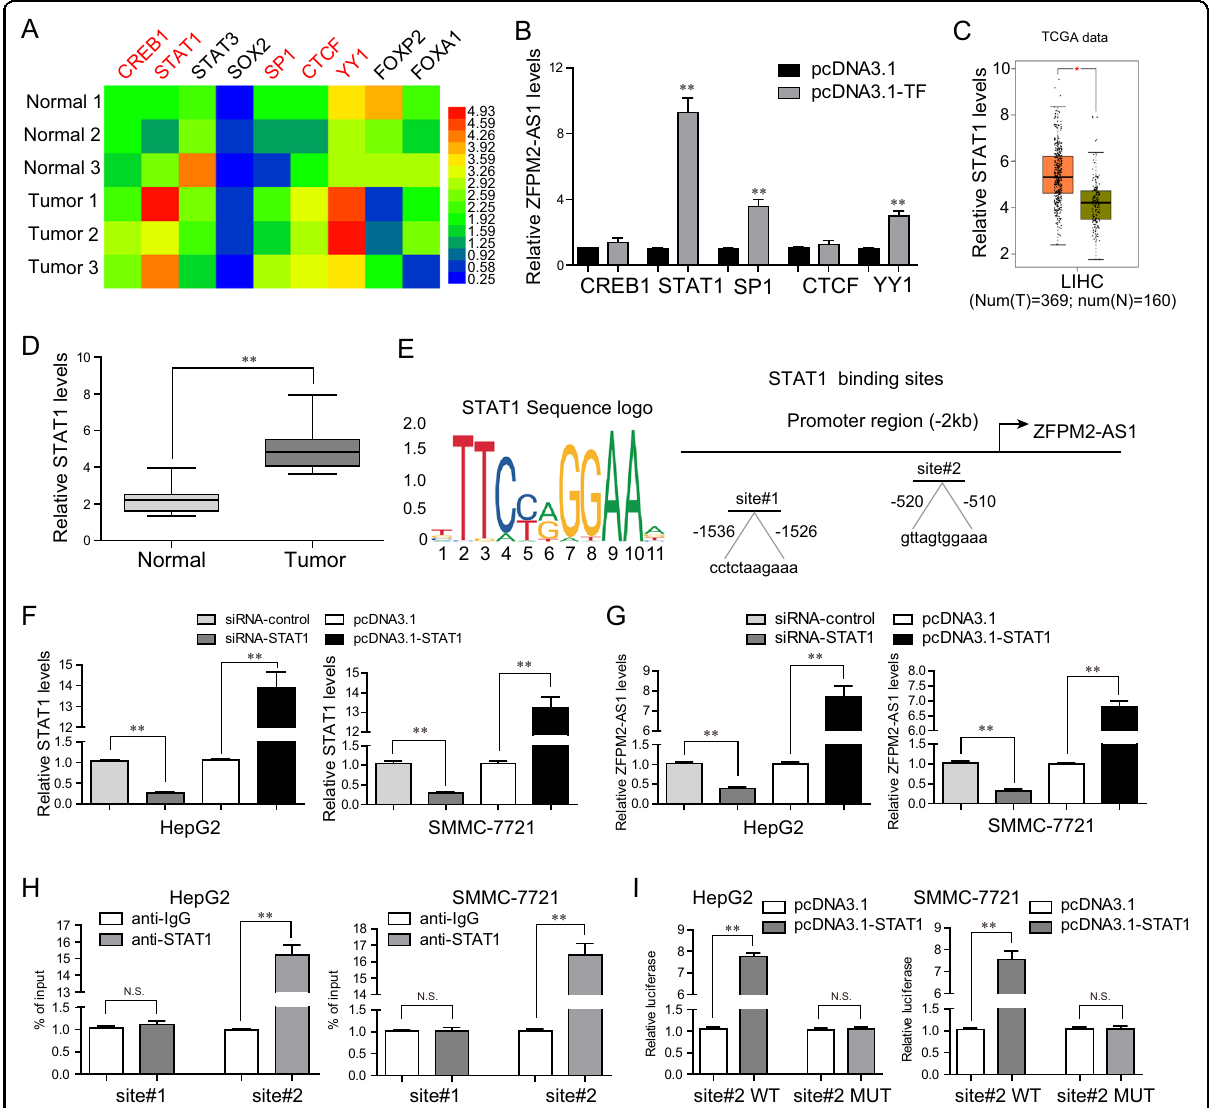
Fig. 2 STAT1 activated ZFPM2-AS1 upregulation in HCC. A Real-time PCR assays evaluated the expression of a panel of transcriptional factors in three paired HCC tumor samples and normal tissues. The results were presented using heatmap form. B Real-time PCR assays determined the levels of ZFPM2-AS1 in HepG2 cells after, respectively, overexpressing CREB1, STAT1, SP1, CTCF, and YY1. C Relative STAT1 expression in HCC was assessed by GEPIA algorithm using TCGA data. D Relative STAT1 levels in HCC specimens from 127 patients. E JASPAR algorithm predicted two biding sites (site#1, site#2) between STAT1 and ZFPM2-AS1 promoter regions. F Relative STAT1 levels in HepG2 and SMMC-7721 cells were detected by qPCR analyses after various treatment. G Real-time PCR assays examined ZFPM2-AS1 expression in HepG2 and SMMC-7721 cells after STAT1 was overexpressed or knocked down. H ChIP assays. I Luciferase reporter assays detected the luciferase activities in HCC cells after transfection with site#2 wild-type (WT) reporter plasmids or site#2 mutant-type (MUT) reporter plasmids. Data are presented as the mean ± SD from three independent experiments. * P < 0.05, ** P <